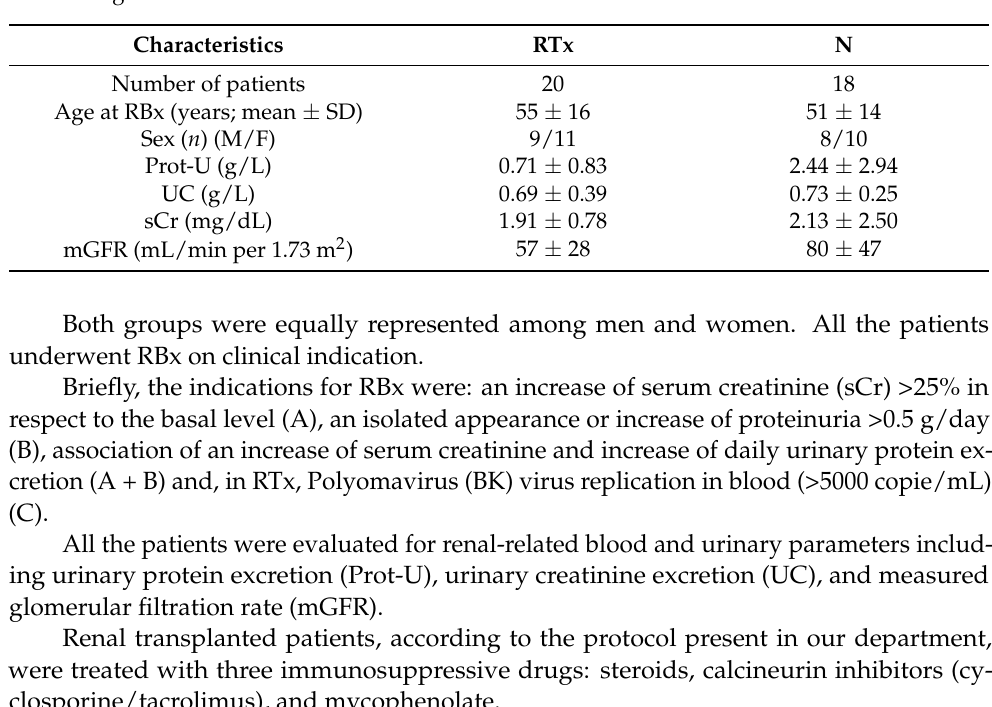
Table 1. Clinical parameters and characteristics of analyzed patients. RBx: renal biopsy; M: Males; F: Females; Prot-U: urinary protein excretion; UC: urinary creatinine; sCr: serum creatinine; mGFR: measured glomerular filtration